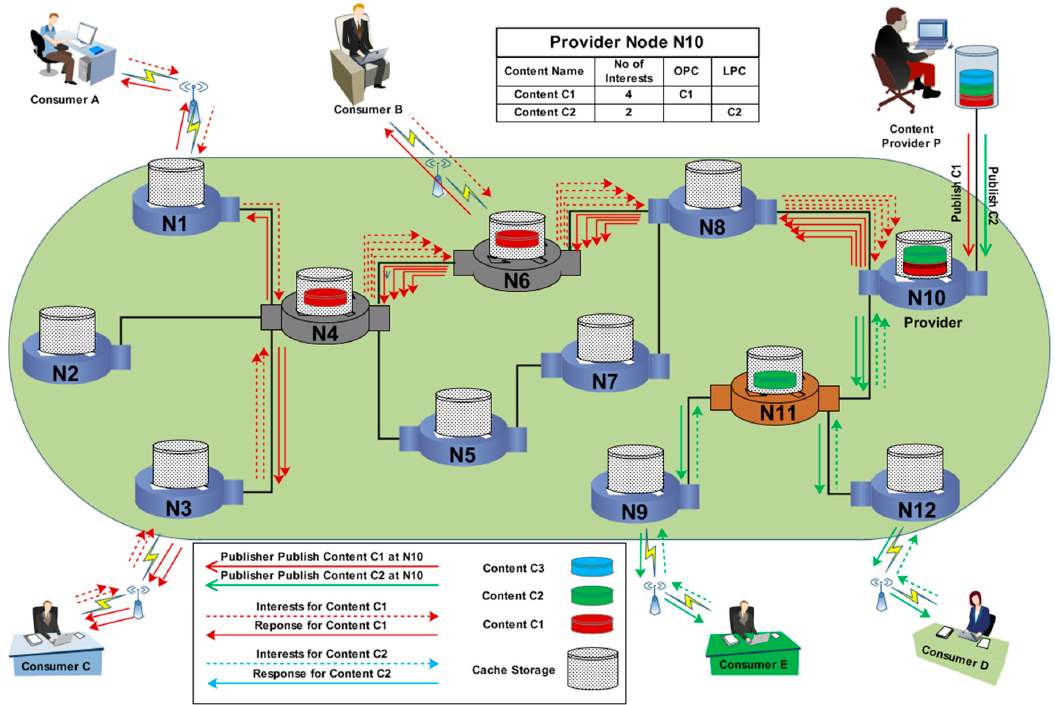
Figure 1. Compound popular content caching strategy.